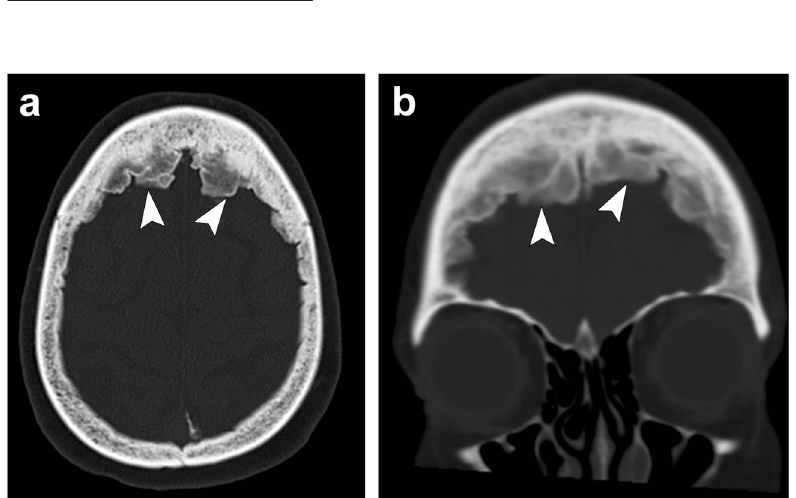
Fig. 25 Hyperostosis frontalis. Axial ( a ) and coronal ( b ) head CT images portray irregular thickening of the inner table of the frontal bone consistent with hyperostosis frontalis ( arrowheads